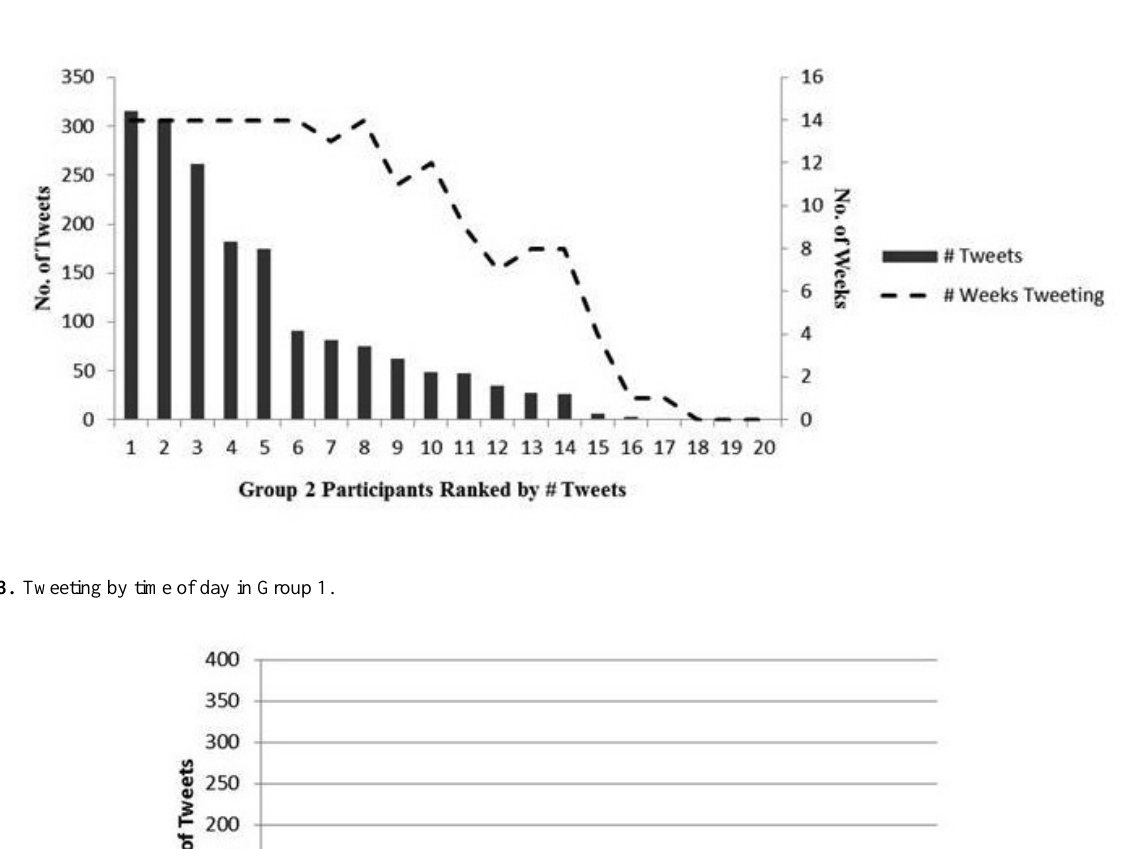
Figure 2. Tweeting volume and duration in Group 2.